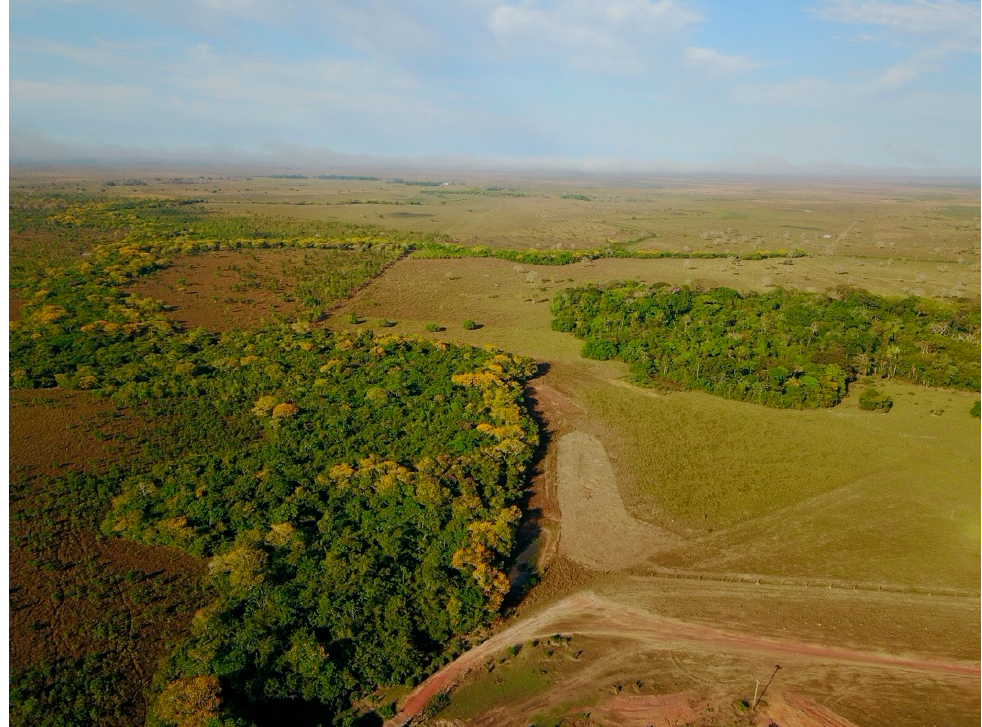
Figure 1. A seasonal stream (left) passes by Santa Maria forest island (right) as it meanders into the surrounding savanna. Gallery forests along the stream are different from the islands of dry forest. (drone photography by Thomas Lee).